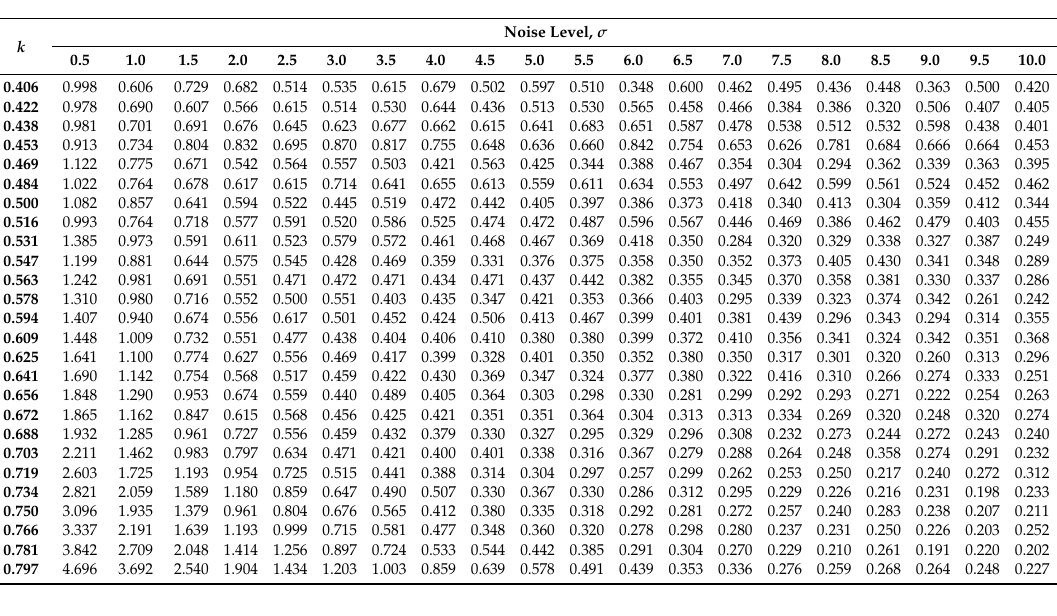
Table A3. For the block size of 32 × 32, MSE levels across a range of noise levels and normalized singular value tail length k